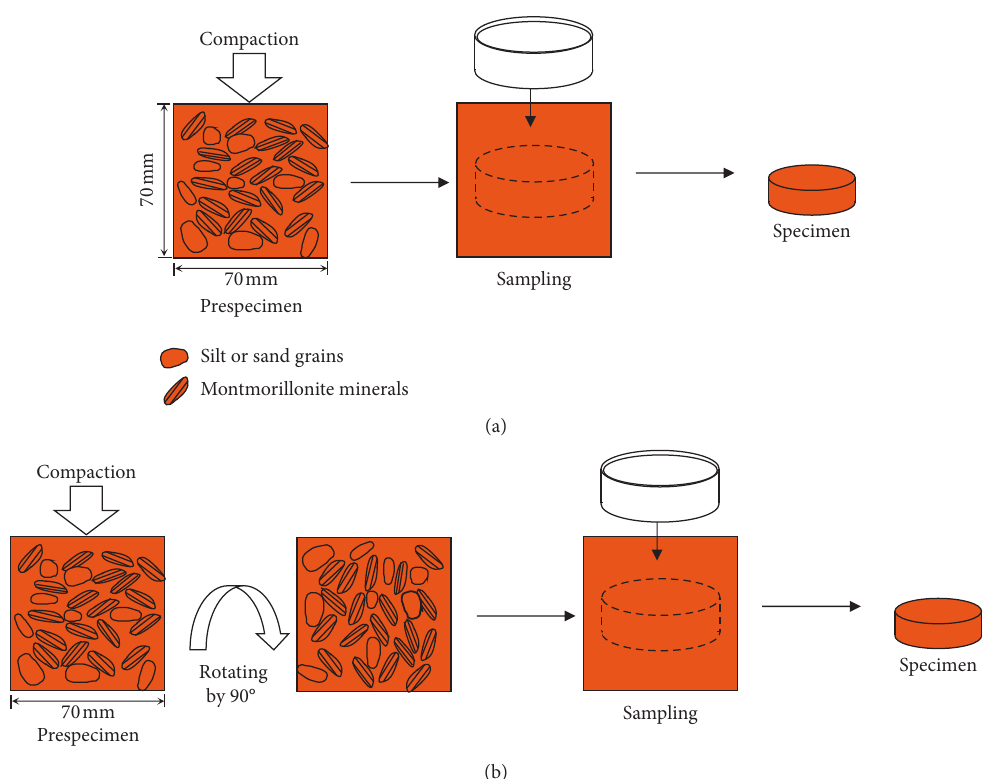
Figure 4: Schematic view of specimen preparation. (a) VS test. (b) LS